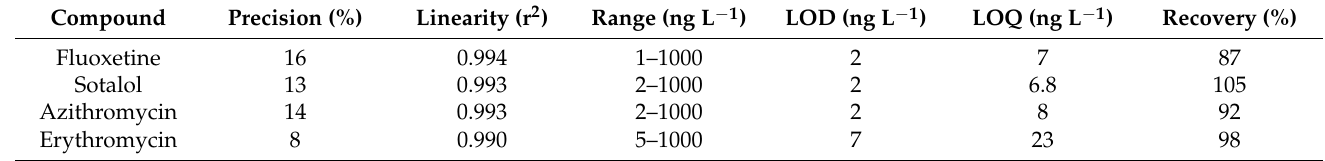
Table 3. LC-MS/MS method performance characteristics for the analysis of